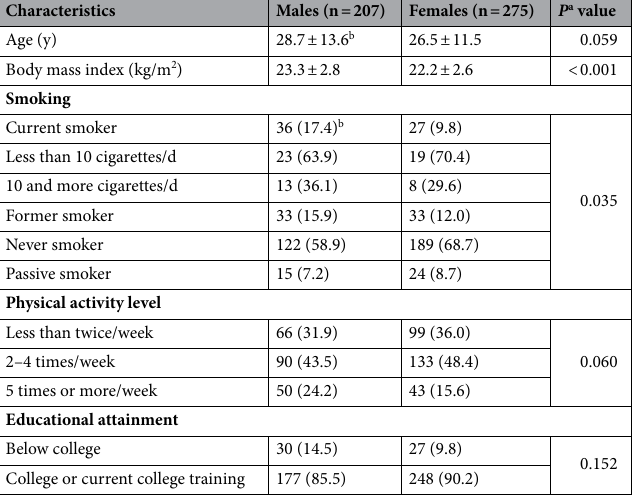
Table 1. Characteristics of study subjects by sex. a P values for sex differences are based on t tests for continuous variables and chi-square tests for categorical variables. b Values are mean ± standard deviation for continuous variables and number (percentage) for categorical